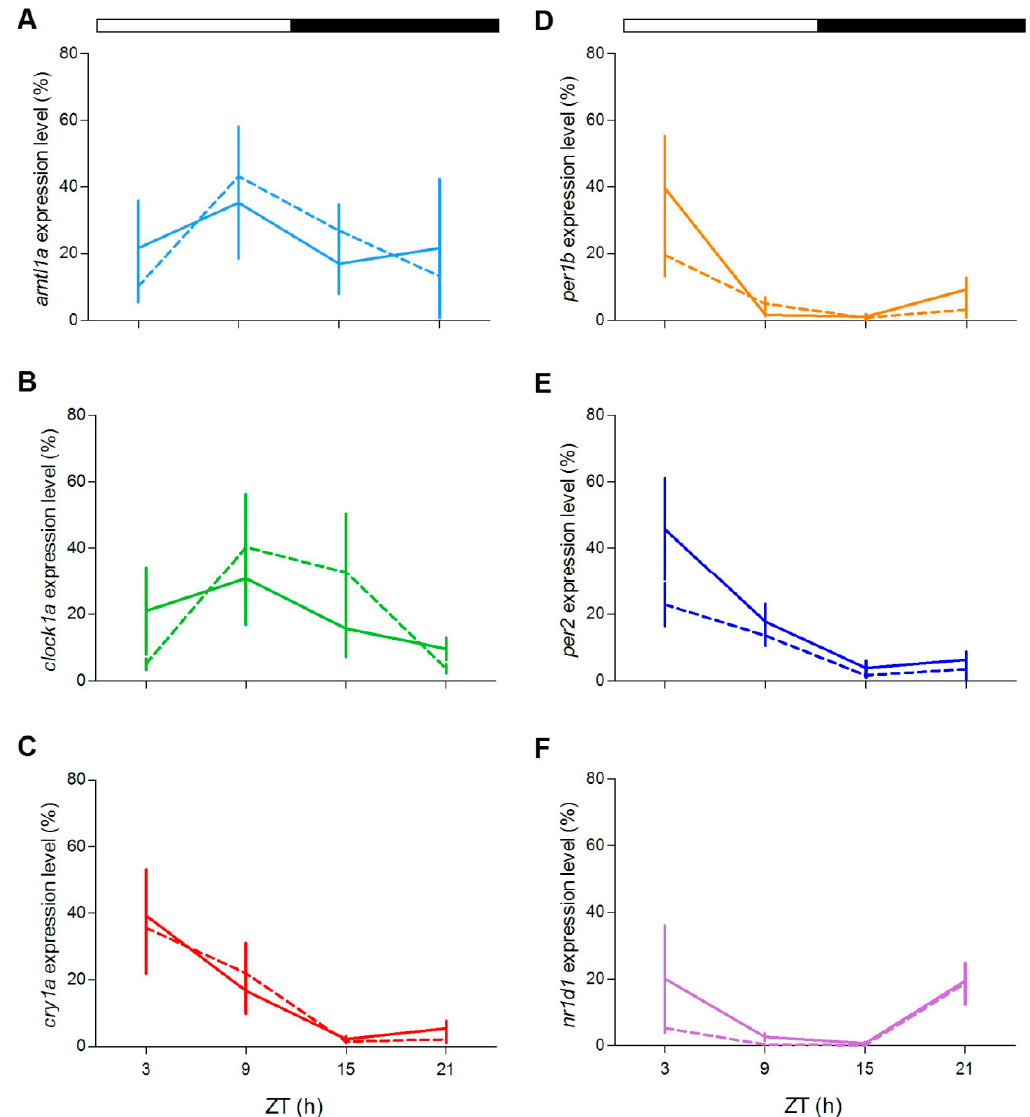
Figure 8. Daily expression levels of clock genes in zebrafish adult liver. qPCR analysis of clock ( A , B , D , F ) and light-regulated clock ( C , E ) gene expression in the liver of zebrafish exposed to LD cycles. For all panels, each point represents the mean ± SEM (n = 4). gr +/+ = solid line; gr − / − = dotted line. For more details see Figure 4.